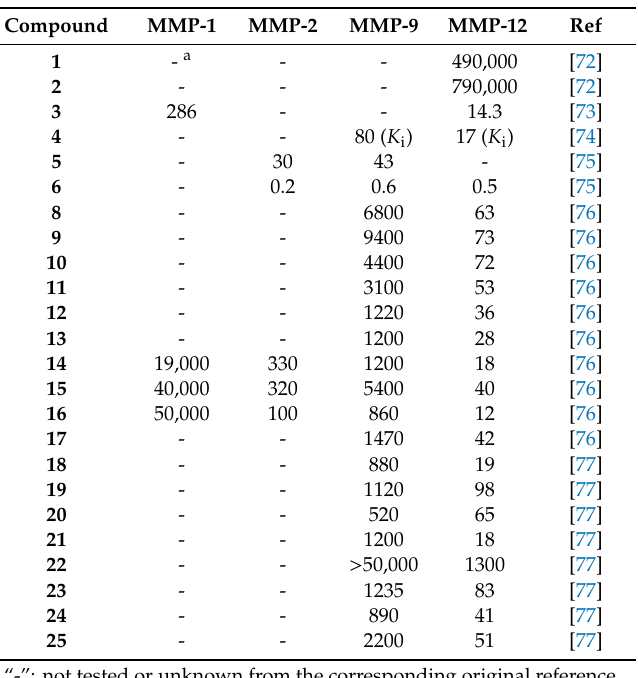
Table 1. Inhibitory activity (IC 50 nM) of sugar-based MMP inhibitors against MMP-1, -2, -9, -12.